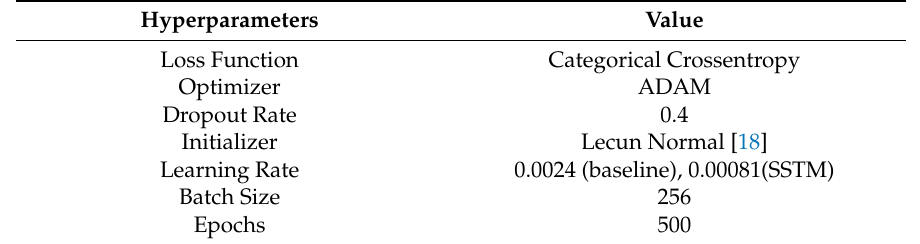
Table 2. Hyperparameters in signal spatial transformer module (SSTM)-based method training.